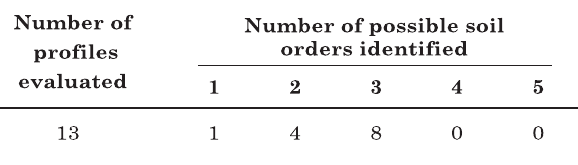
Table 4. Confounding Index from simplified descriptive comparison for 13 profiles with the Spectral